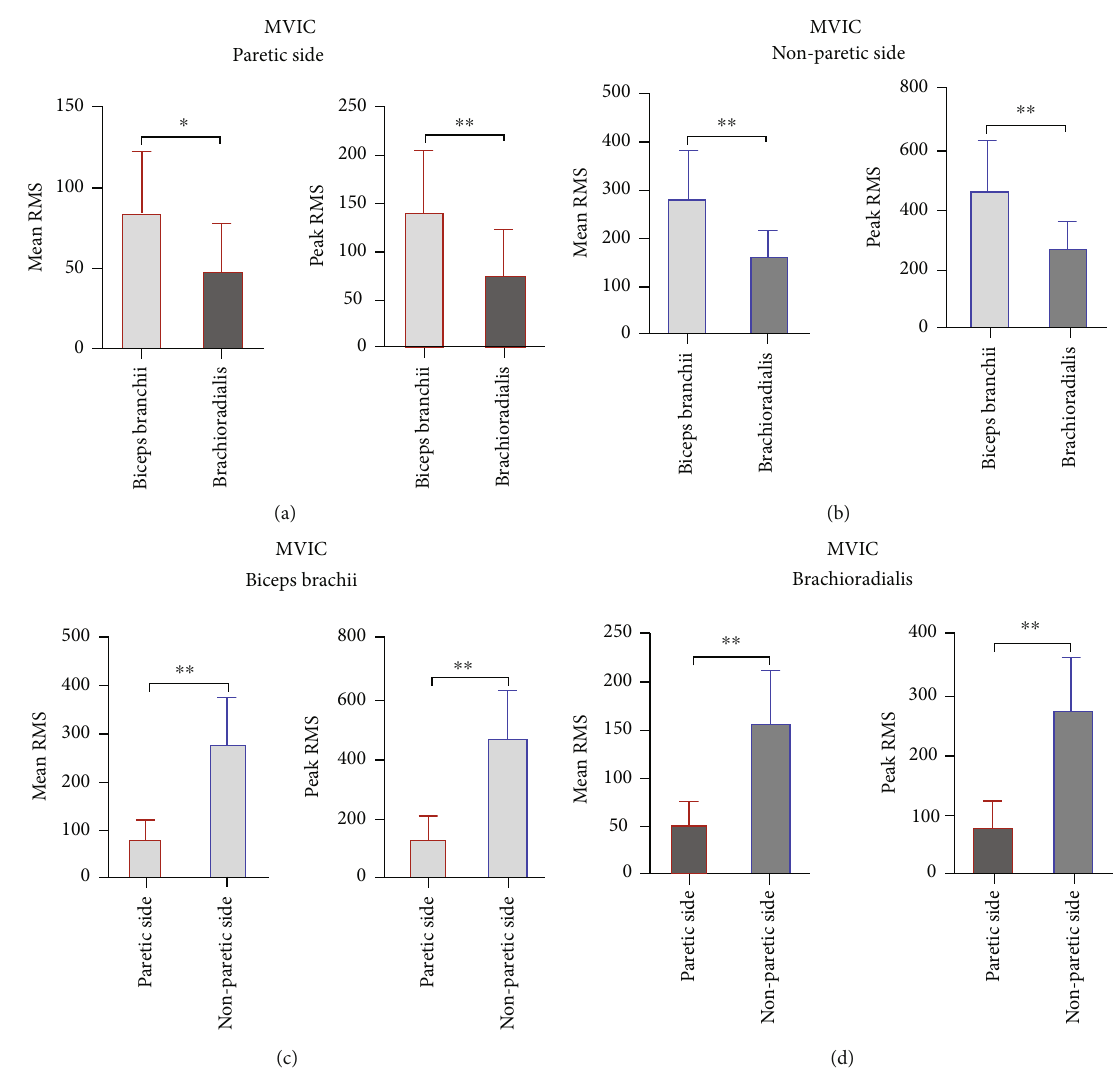
Figure 3: sEMG signals of the elbow fl exor muscles (the biceps brachii and brachioradialis) during MVIC. (a) Mean RMS values of the biceps brachii and brachioradialis during MVIC on the paretic side. (b) Peak RMS values of the biceps brachii and brachioradialis during MVIC on the nonparetic side. (c) Mean RMS values of the biceps brachii during MVICon the paretic and nonparetic sides. (d) Mean RMS values of the biceps brachii during MVIC on the paretic and nonparetic sides. sEMG: surface electromyography; MVIC: maximum voluntary isometric contraction; RMS: root mean square; ∗ p < 0 : 05 ; ∗∗ p < 0 : 005